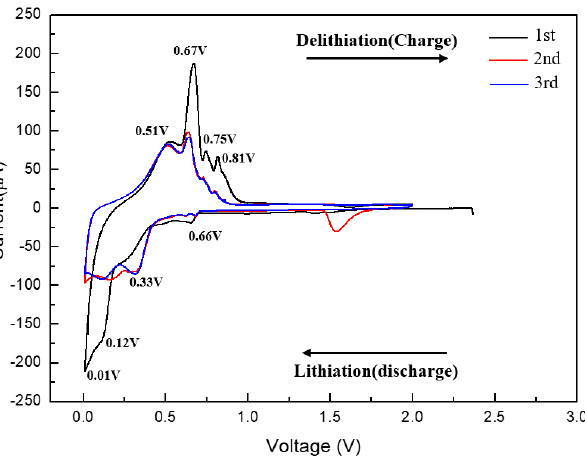
Figure 8. Cyclic voltammetry of the TiNi(RT)/Sn/TiNi electrode at 0.1 mV/s in the voltage window of 0.01~2.0 V (vs. Li + /Li).